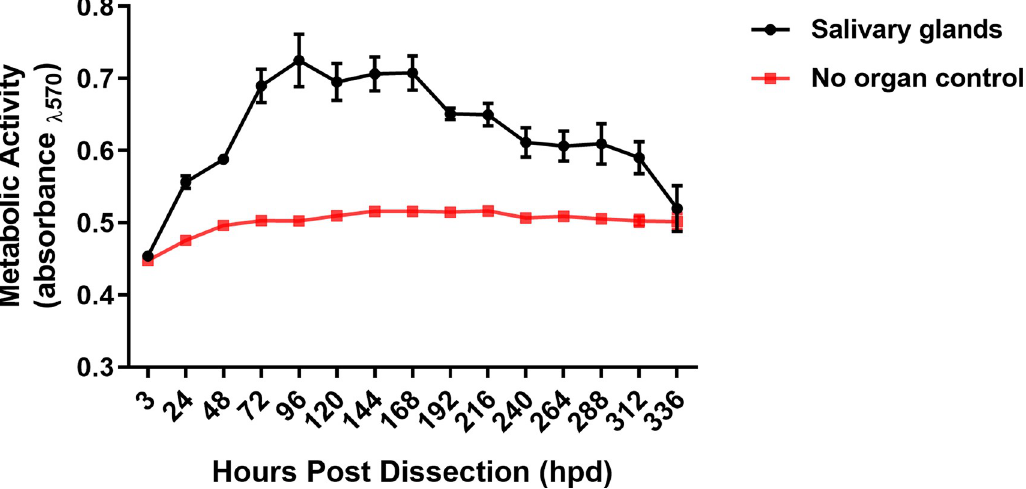
Fig 1. Metabolic activity of SG cultures from male ticks. Metabolic activity of male Ixodes scapularis salivary gland (SG) cultures was assessed using a fluorescent resazurin salt-based viability assay. Absorbance values were taken at 3 and 24 hours post- dissection (hpd), then every 24 hours thereafter to 336 hpd. Each experimental well contained 1 pair of SGs and was accompanied by a corresponding no-organ control well. The experiment was completed with 3–4 biological replicates per timepoint. Error bars indicate standard errors of the means, and data are representative of 3 machine replicates for each sample during viability reads.